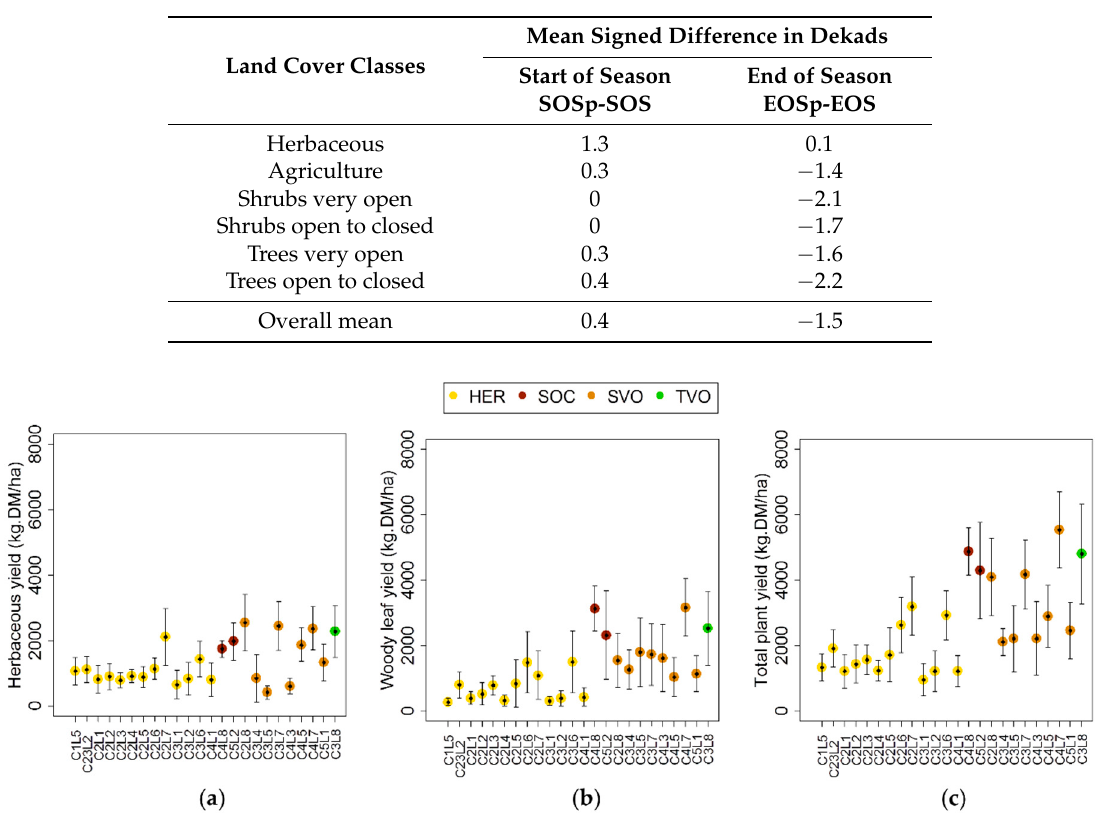
Figure A1. Averaged ( a ) herbaceous, ( b ) woody leaf and ( c ) total plant yield of the 24 sites used in this study and their corresponding standard deviation (error bar) for the 2000–2015 period.